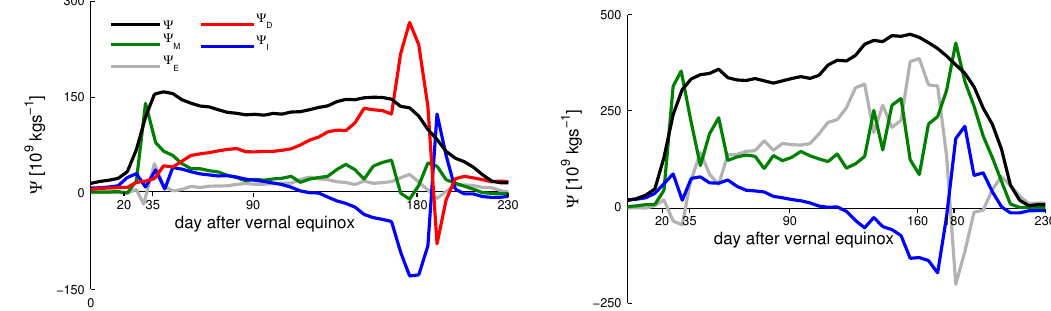
Fig. 9. Strength of the winter cell ( 9 ) for seasonally varying insolation as a function of time, and decomposition of 9 into contributions from the mean circulation ( 9 M ), eddies ( 9 E ), vertical diffusion ( 9 D ), and inertia ( 9 I ). Left panel: standard simulation (U1V1T1). Right panel: simulation with suppressed vertical diffusion of zonal and meridional momentum (U0V0T1).